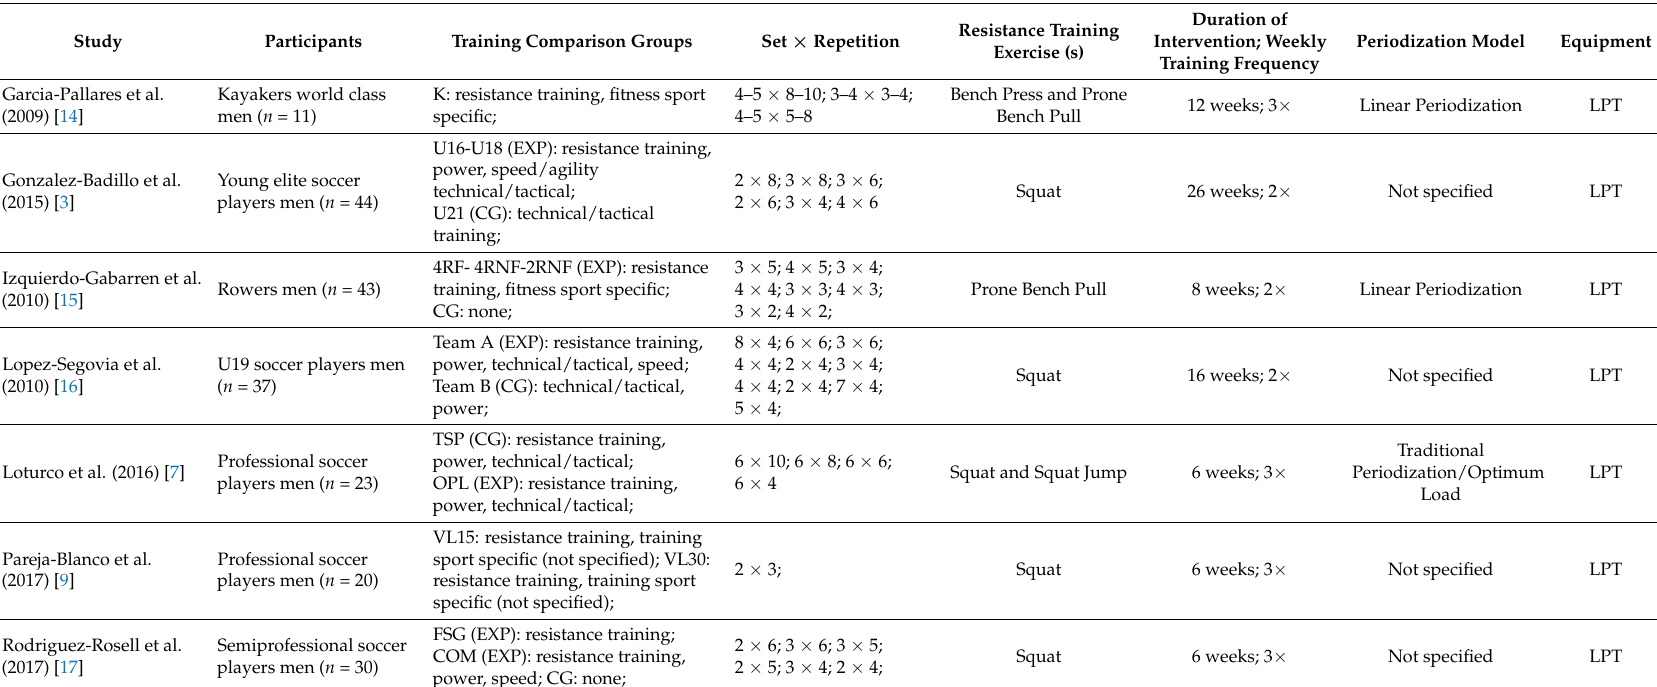
Table 1. Overview of studies meeting inclusion